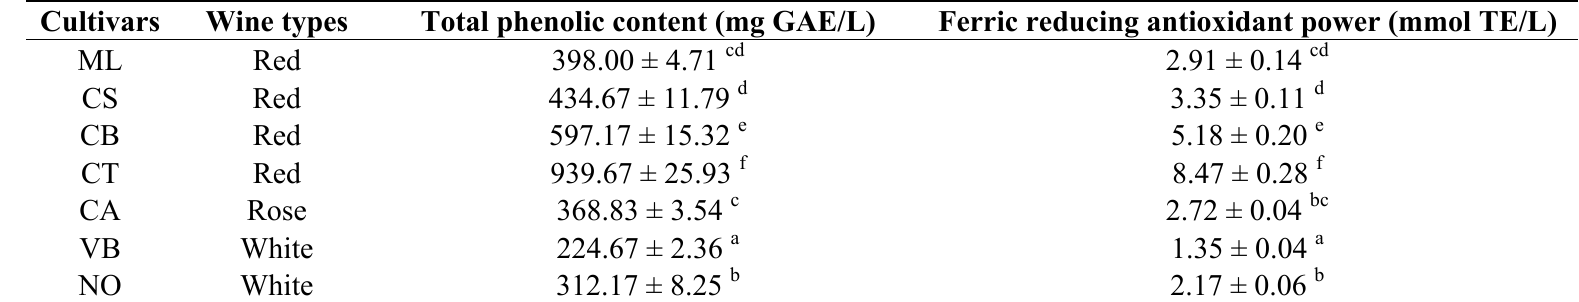
Table 2. The total phenolic concentrations and antioxident capacities in the wines from different grape